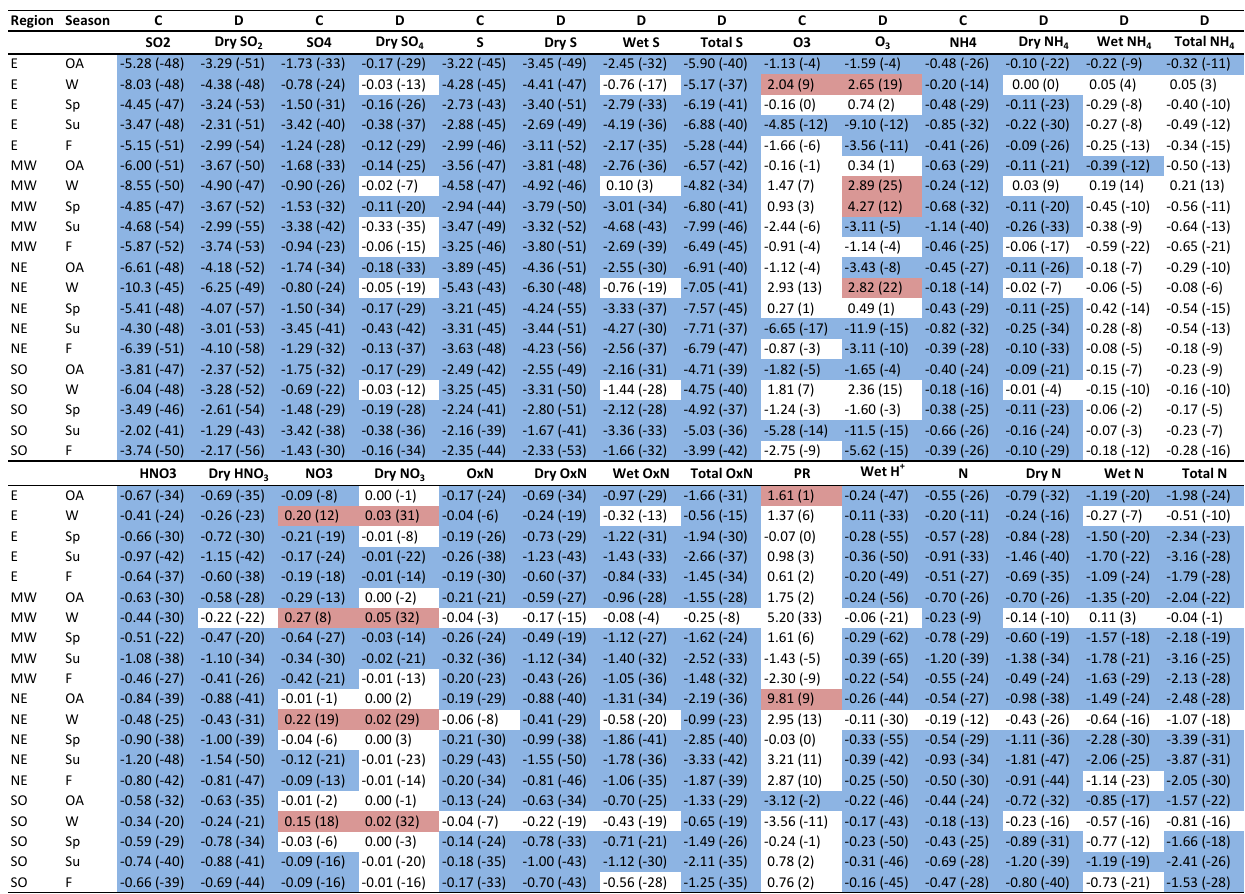
Figure 4. P1-to-P4 changes expressed in Table 3 units and as relative differences (%); see Table 2 for definitions of column headings.